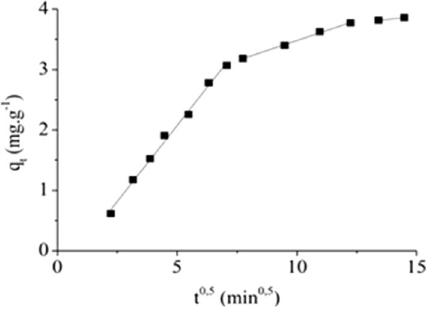
Table 2 Parameters of the intraparticle diffusion model for